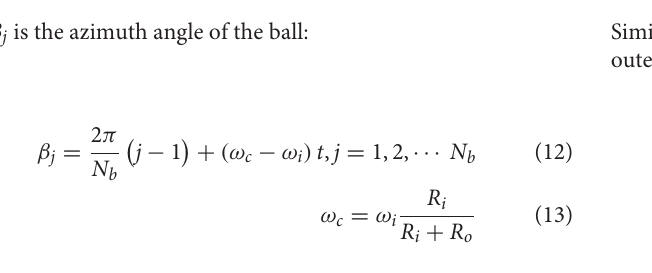
β j is the azimuth angle of the